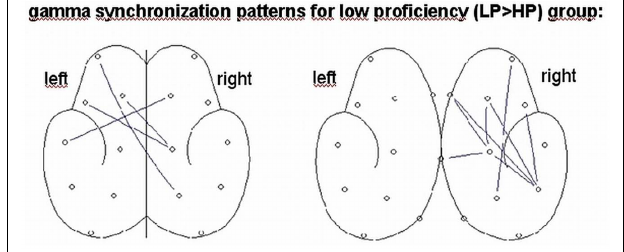
FIGURE 7 | Connectivity brain maps visualizing the most synchronized and exact electrode positions (synchronization patterns) within the strongly synchronized cluster in the gamma band for the interhemispheric connections only (left panel) and the within hemisphere (left and right) connections, for the condition L2 English in the LP > HP group.